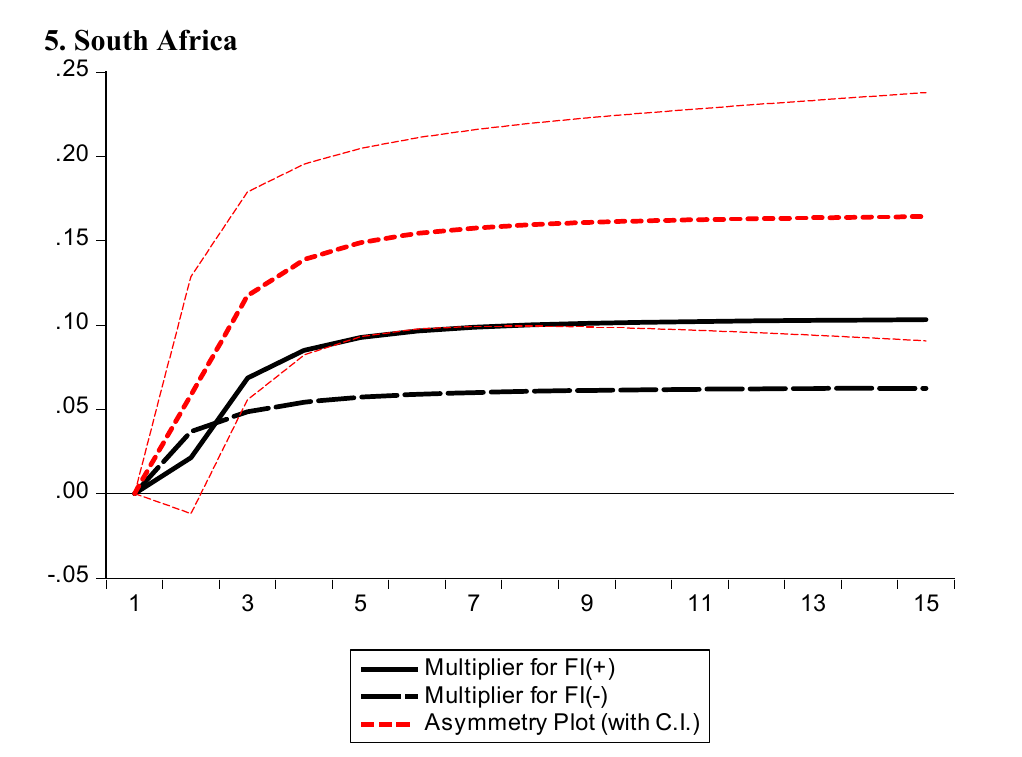
Figure 2. Multiplier graph for non-renewable energy consumption.